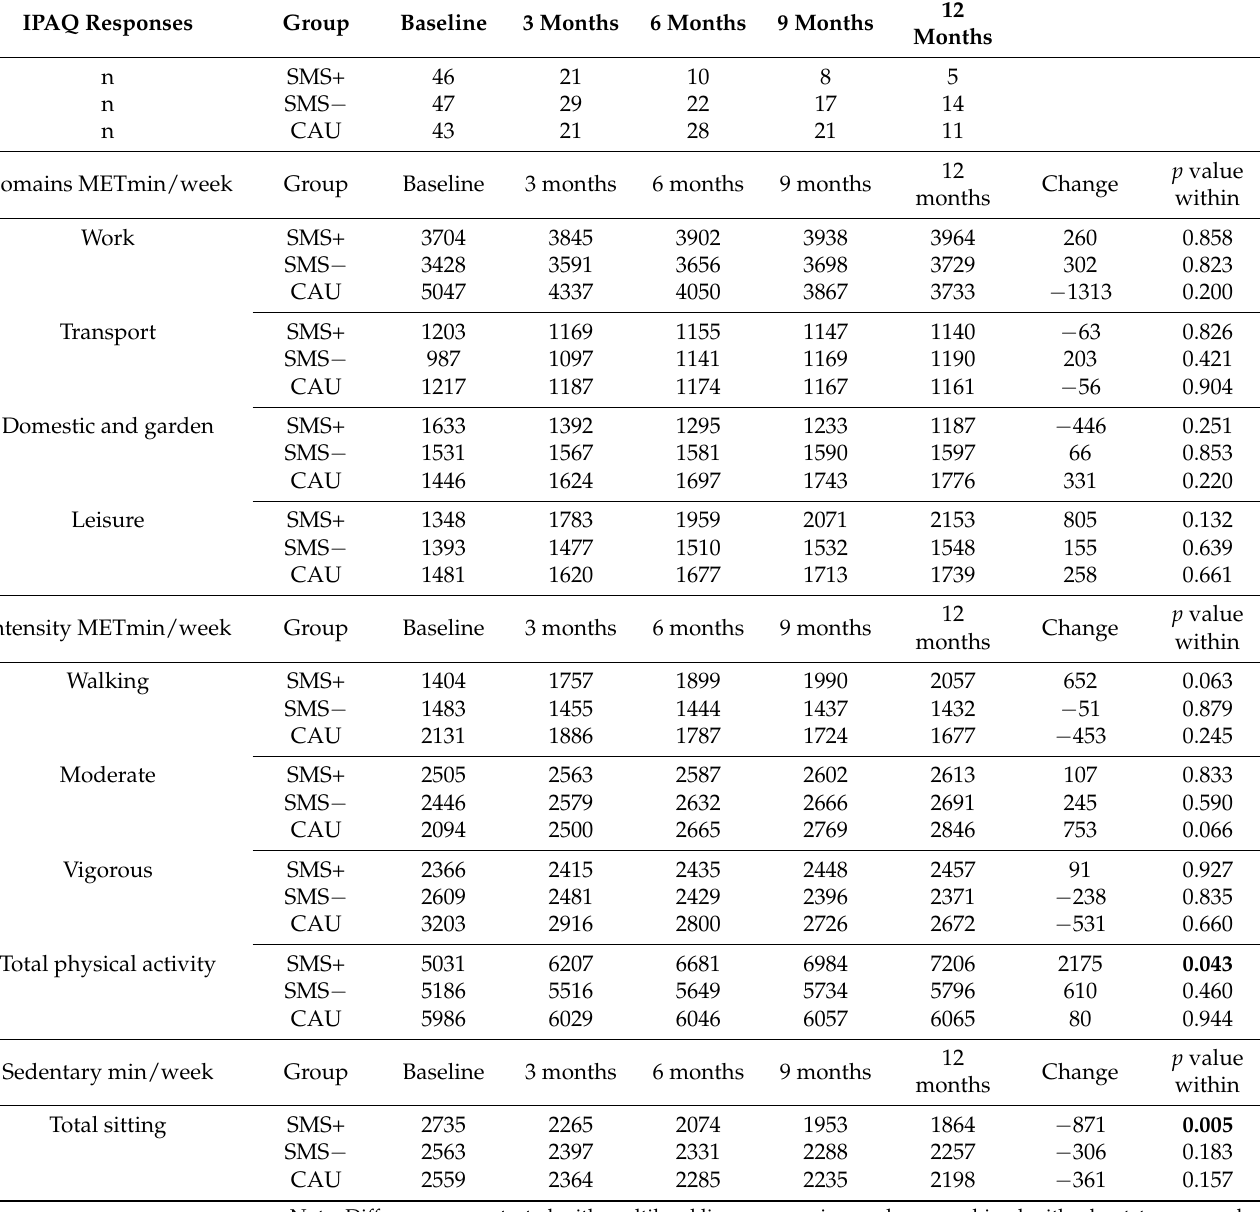
Table 4. Within-group changes in METmin/week from baseline to 12